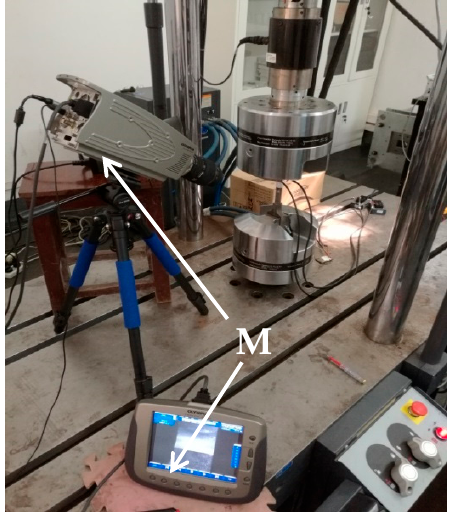
Figure 5. Tensile tests setup-Microscopy System of KEYENCE(M).